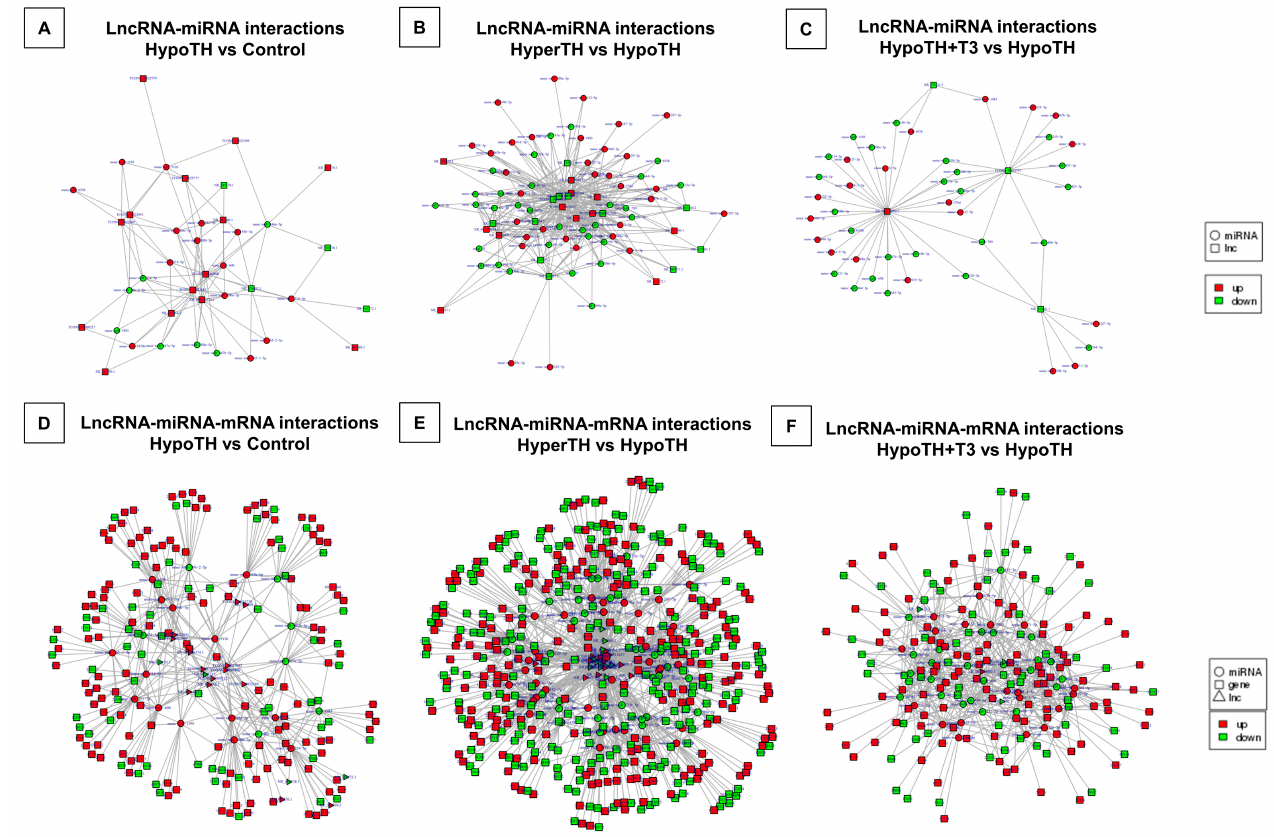
Figure 7. LncRNA-miRNA and lncRNA-miRNA-mRNA correlation analyses. Three groupwise comparisons identified the ( A – C ) lncRNA-miRNA and ( D – F ) lncRNA-miRNA-mRNA